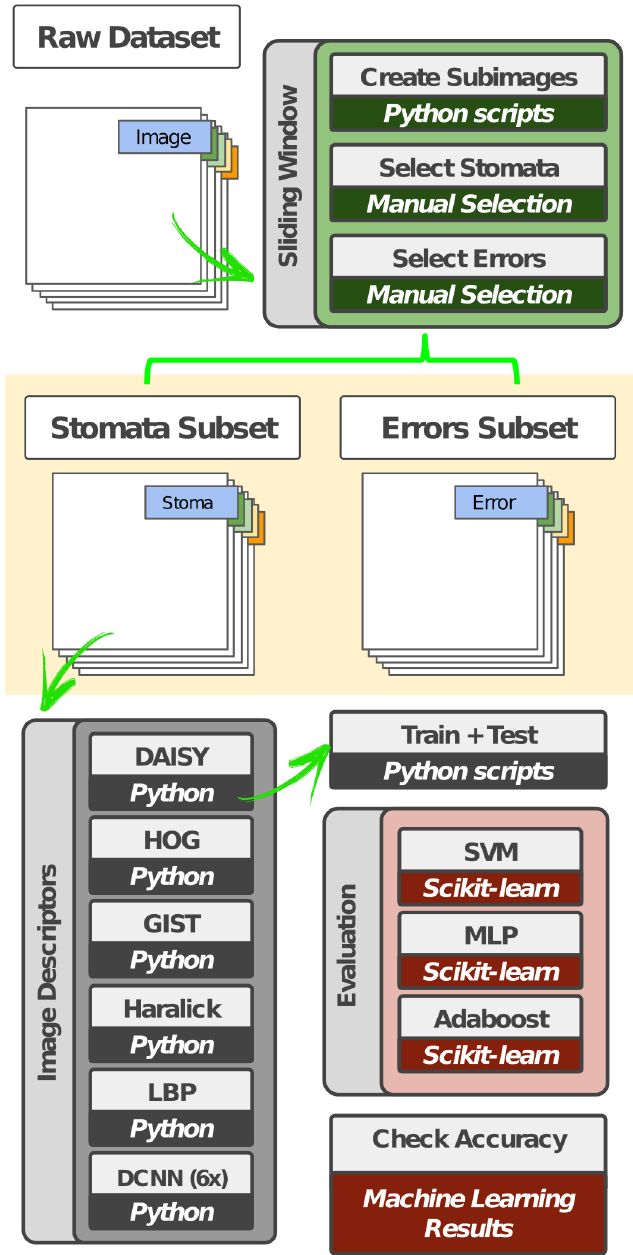
Fig 3. Visual representation of the combination of feature extraction approaches employed and classification algorithms to identify stomata. Based on a manual selection of microscope subimages representing stomata and errors, several image descriptors were employed (DAISY, Oriented Gradient Histogram—HOG, Haralick Texture Features, Local Binary Patterns—LBP, GIST and Deep Convolutional Neural Networks—DCNN) and used to produce features to be used as input to machine learning techniques (Support Vector Machine—SVM, Multilayer Perceptron— MLP, and Adaboost) for identifying stomata.